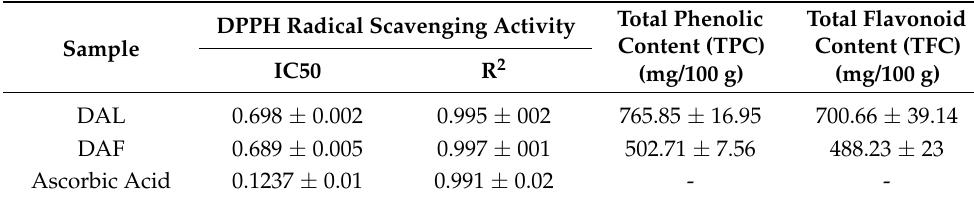
Table 1. Comparison of DPPH radical scavenging activity, total phenol, and flavonoid content of DAL and